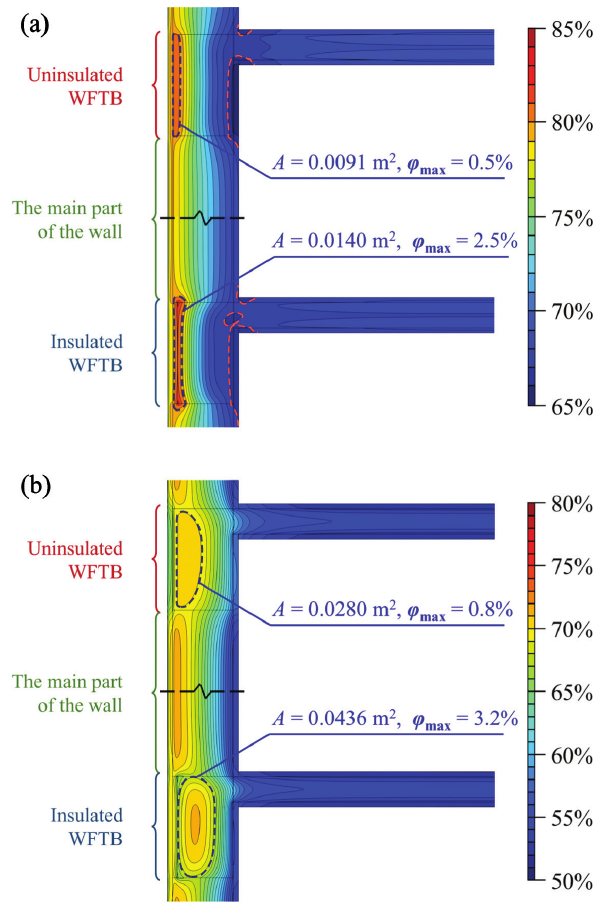
within WFTBs ave,t